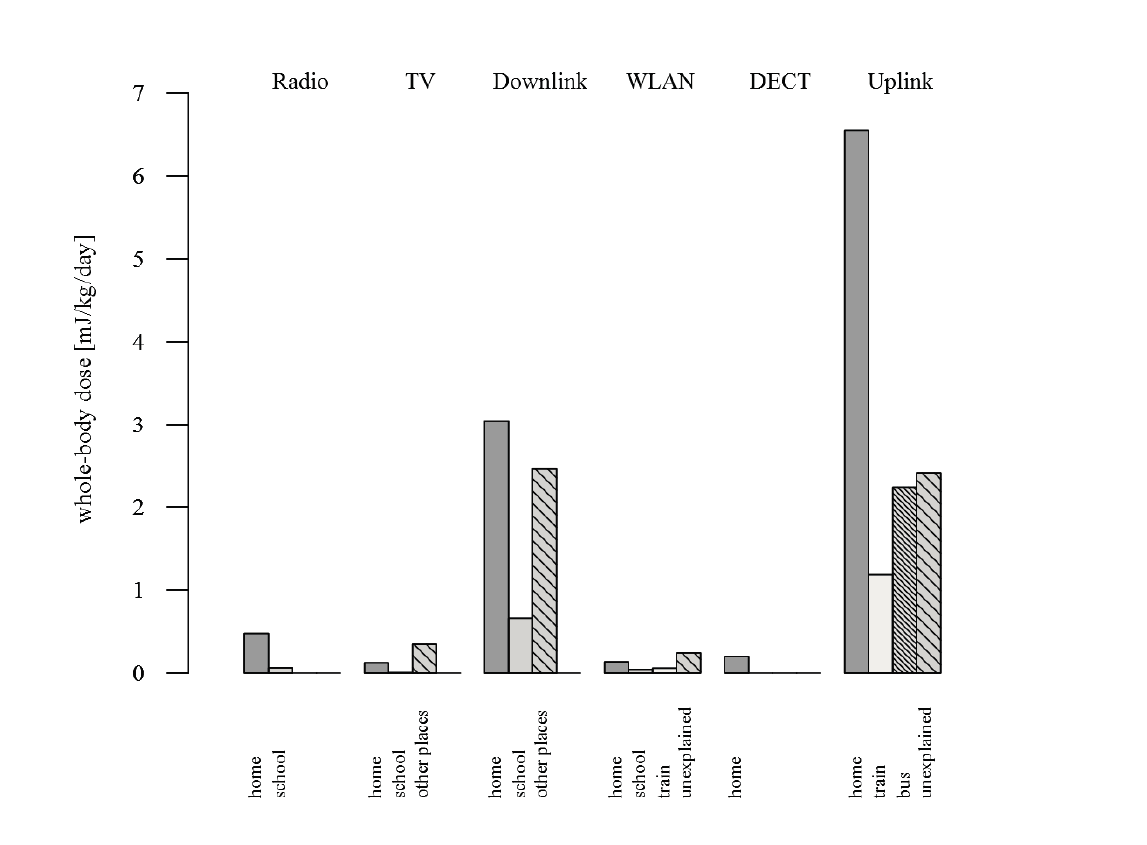
Figure 2. Mean daily cumulative whole-body dose for the far-field exposure at different locations; The same pattern was found for the brain